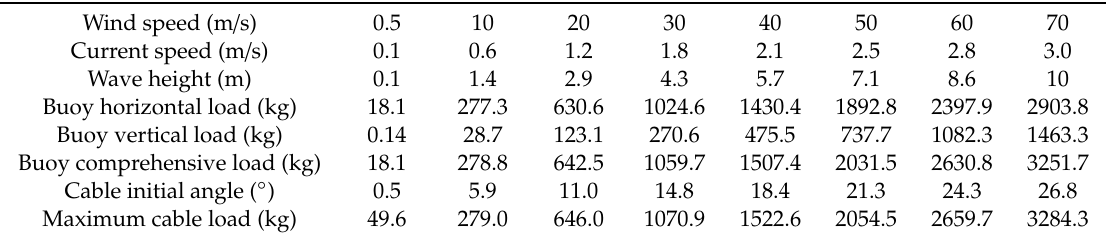
Table 1. Mooring forces of buoys and cables with respect to di ff erent wind, waves, and currents. Wind speed (m / s)